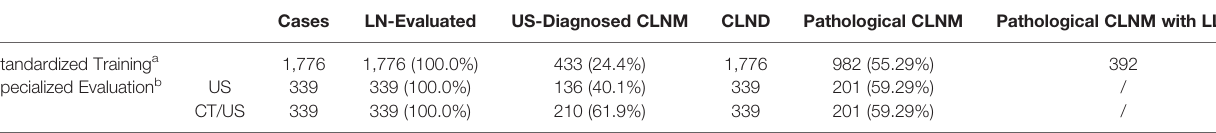
TABLE 2 | The basic situation of preoperative US evaluation in our single medical